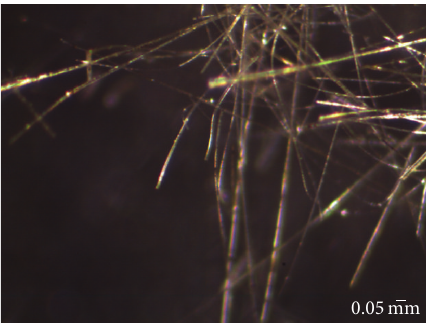
Figure 5: Recycled glass wool seen under the microscope with five enlargements.